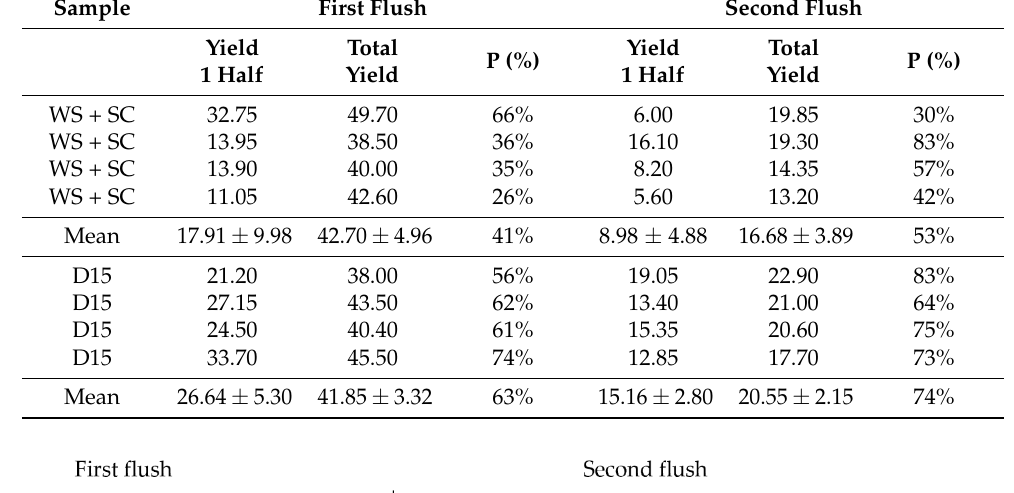
Table 2. P expressed in percentage of P. ostreatus grown on WS + SC and D15.